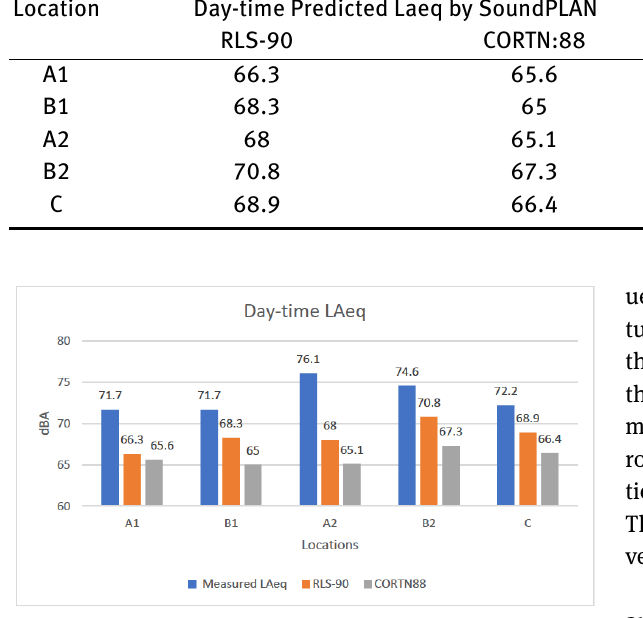
Figure 12: Chart showing a comparison between different standards for day-time